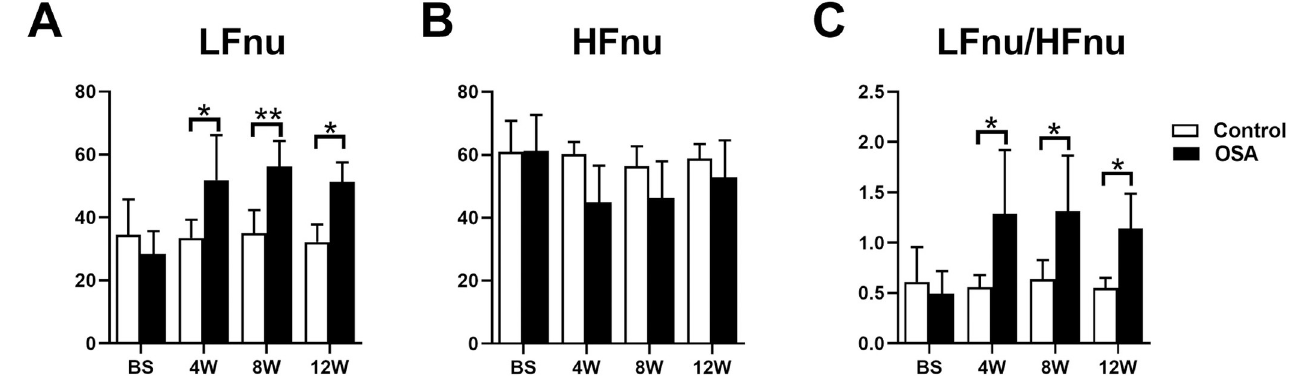
Fig 3. Comparison of HRV between the two groups. � P < 0.05, �� P < 0.01 compared to control group.